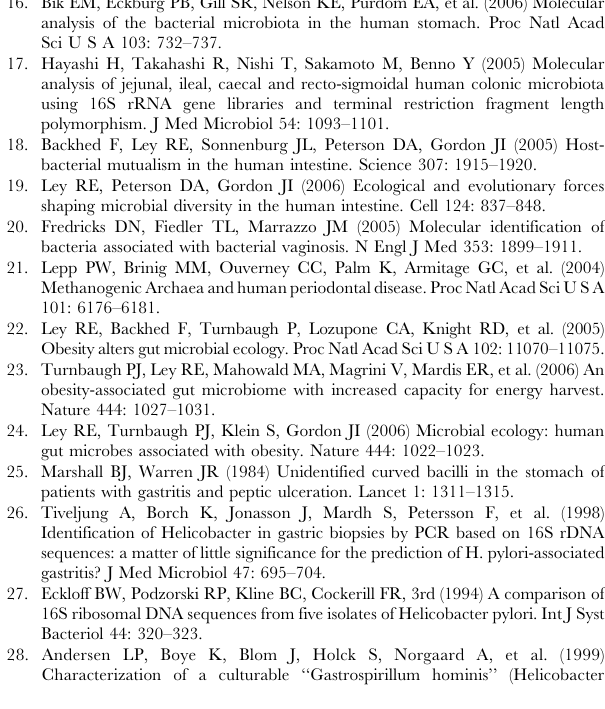
Figure S1 Detailed taxon tree Figure S2 Species richness estimate Found at: doi:10.1371/journal.pone.0007985.s002 (0.97 MB TIF) Figure S3 Correlation between qPCR and 16S rRNA cloning and sequencing Found at: doi:10.1371/journal.pone.0007985.s003 (0.98 MB TIF) Figure S4 Lack of correlation between patient age and Firmicutes or Streptococcus abundance Found at: doi:10.1371/journal.pone.0007985.s004 (2.01 MB TIF) Figure S5 Harsh washing does not remove the bacteria from the biopsies